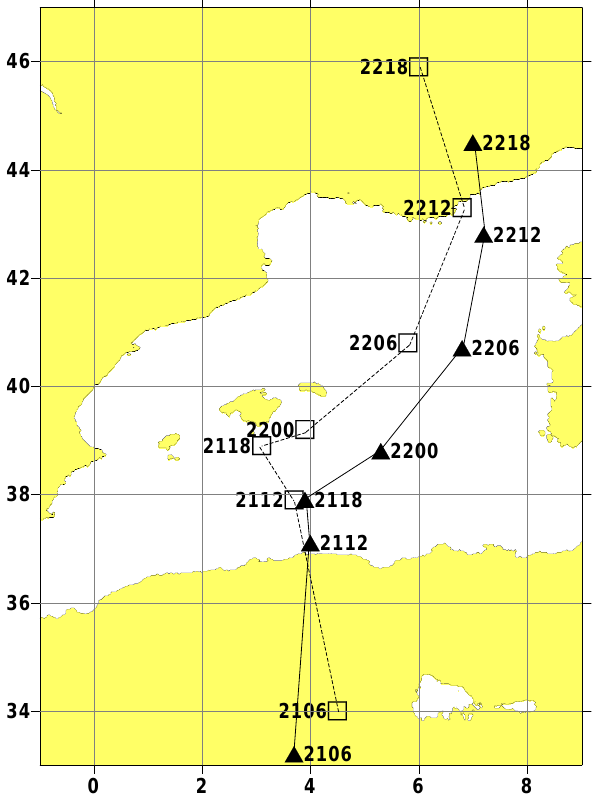
Fig. 16. Position of the cyclone centre as simulated by the C21– 23 (triangles) and NT21–23 (squares) experiments. Date labels are presented in DDHH format.